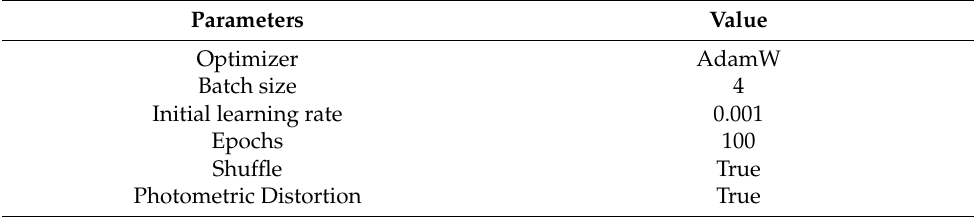
Table 1. Experimental parameters. Parameters Value Optimizer